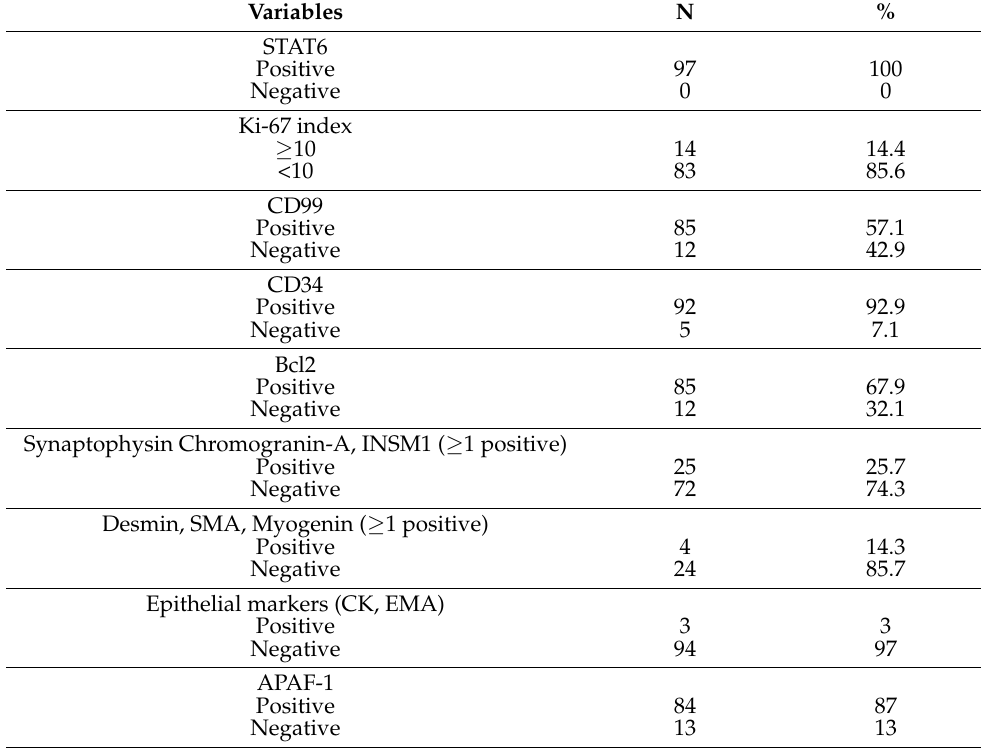
Figure 1. ( A ) Soft tissue solitary fibrous tumor (SFT) with spindle/ovoid growth pattern and fibrocollagenous tissue, hematoxylin and eosin (H&E) 40 × . ( B ) SFT with collagenous stromal tissue and focal hemangiopericytoma-like pattern, H&E 40 × . ( C ) Dedifferentiated SFT with abrupt transition between a well-differentiated area with a patternless appearance and dedifferentiated zone with round cell sarcoma appearance, H&E 40 × . ( D ) A lipomatous/fat-forming SFT with mature adipocytes intermixed with spindle-ovoid cells, H&E 20 × . ( E ) Myxoid SFT, H&E 20 × . ( F ) SFT with multinucleated/giant stromal cell, H&E 20 × . Table 1. Solitary fibrous tumor clinical data (N = 97). Table 4. Solitary fibrous tumor. Immunohistochemistry (N =